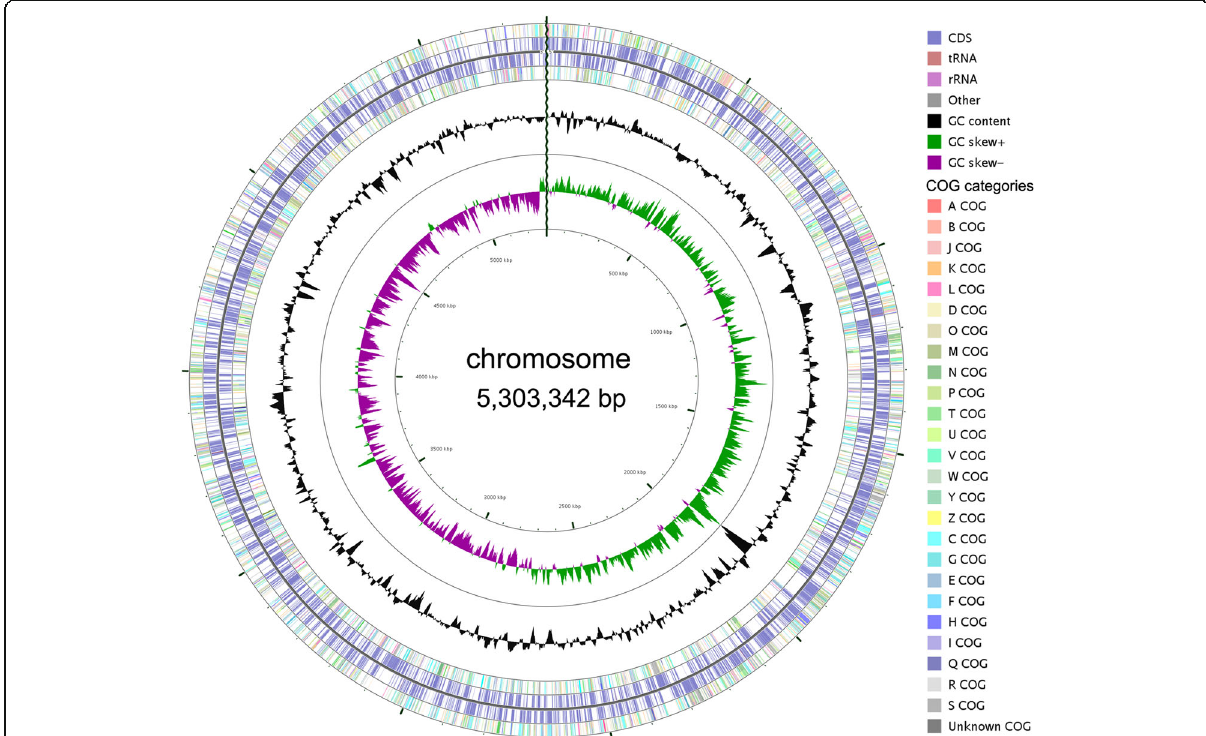
Fig. 3 Circular map of the chromosome of the Kosakonia oryzae strain Ola 51 T . From outside to the center: CDS on forward strand colored according to their COG categories (oranges/reds: information storage and processing; greens/yellows: cellular processes and signaling; blues/ purples: metabolism; grays: pooly characterized), CDS and RNA genes on forward strand, CDS and RNA genes on reverse strand, CDS on reverse strand colored according to their COG categories, GC content, and GC skew. The circular map was generated by CGView [44]